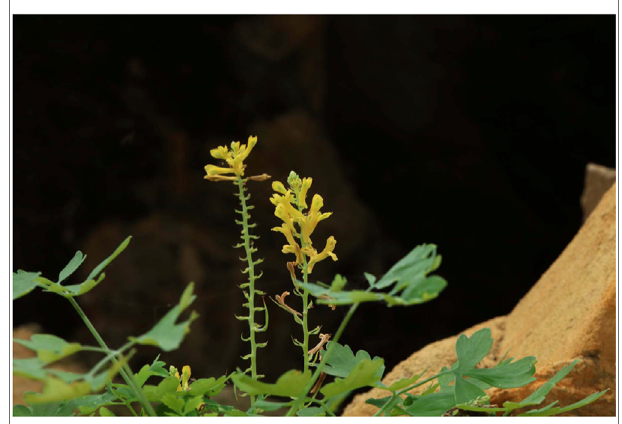
FIGURE 1 | Plant morphology of CSB (Photographed and provided by Jun